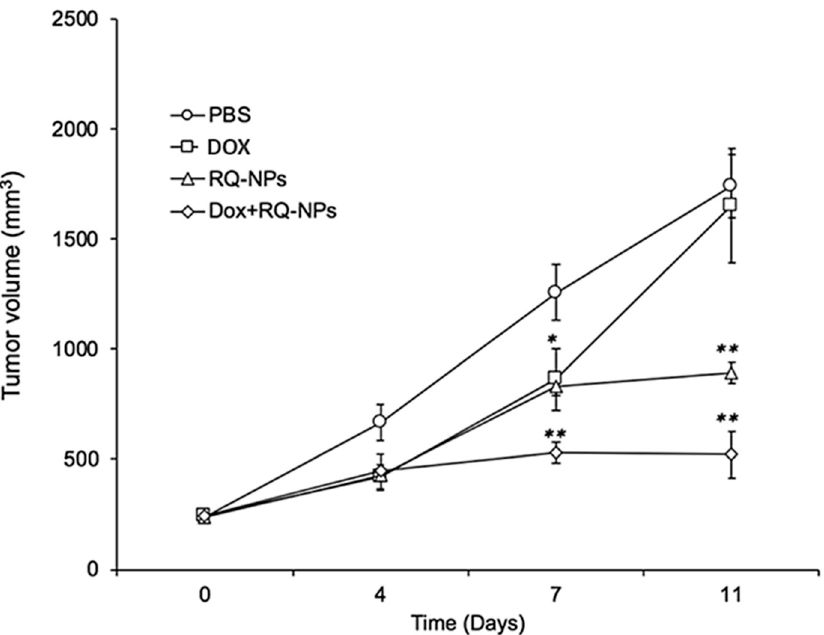
Figure 3. E ff ect of DOX + RQ-NPs, doxorubicin (DOX), and their combination on tumor volume (mm 3 ). Figure 3. Effect of DOX + RQ-NPs, doxorubicin (DOX), and their combination on tumor volume Values are expressed as the mean ± SEM. * p < 0.05, ** p < (mm 3 ). Values are expressed as the mean ± SEM. * p < 0.05, ** p < 0.01.